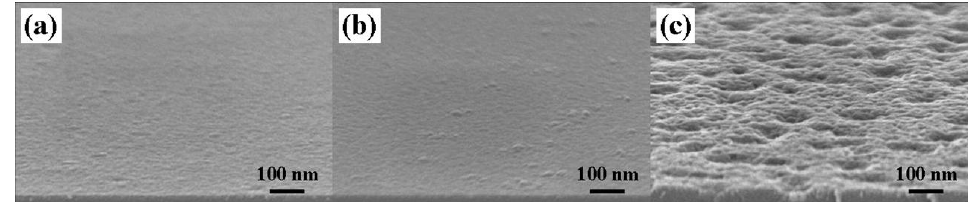
Figure 1. SEM images of PECVD TiCl 4 -based Ti films on Si surface at process temperatures of ( a ) 550 ˝ C;